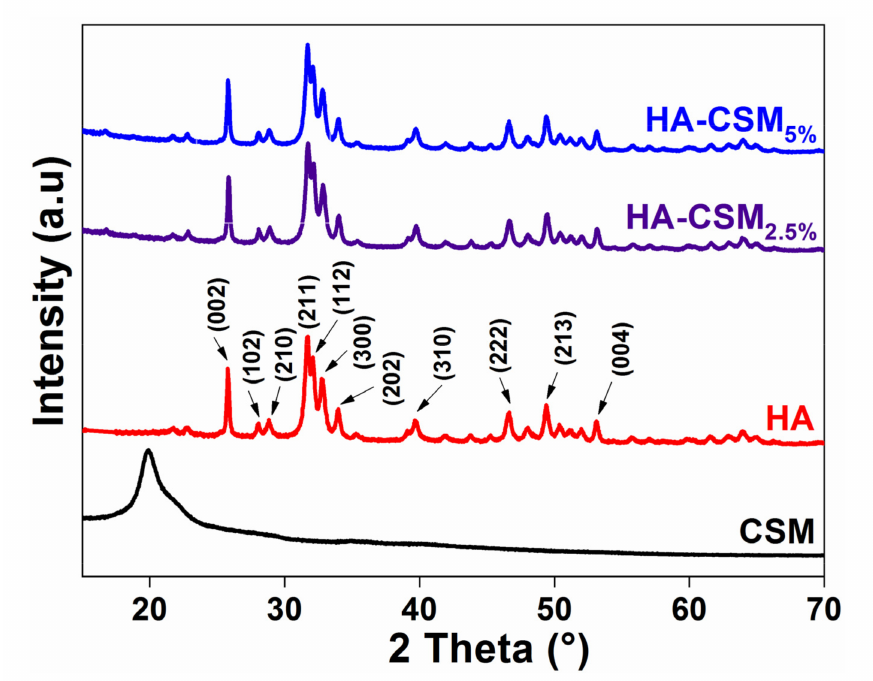
Figure 1. XRD patterns of chitosan (CSM), hydroxyapatite (HA), and hydroxyapatite-chitosan composites